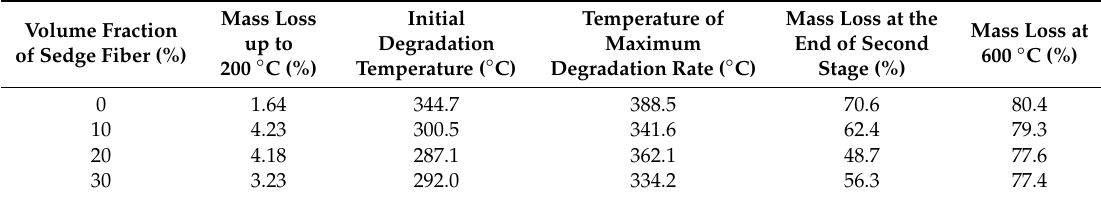
Table 12. Thermogravimetric parameters for the neat epoxy and the CM sedge fiber-reinforced composite.